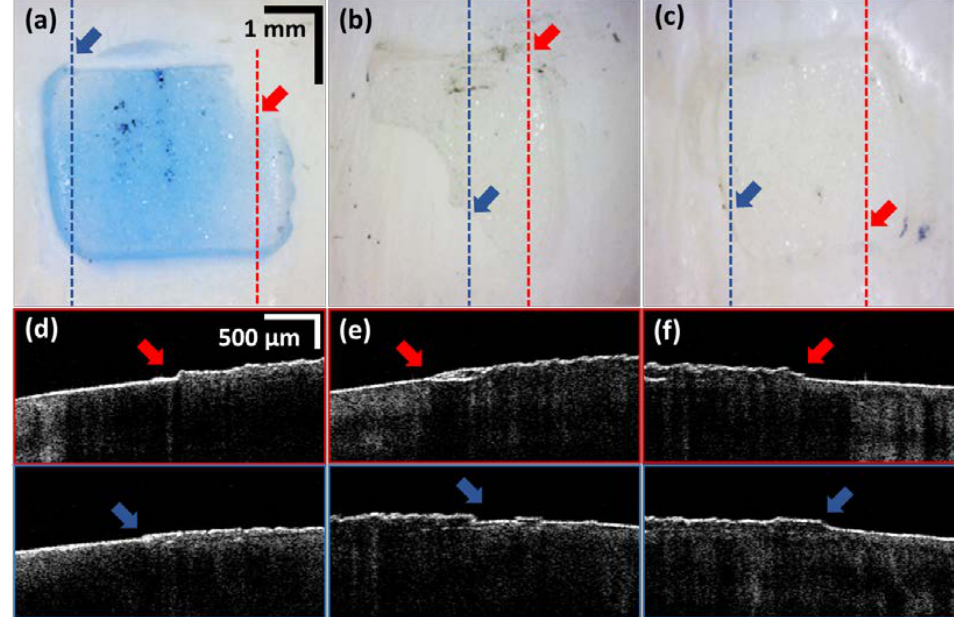
Figure 4. The images of the optical microscope of the samples and the cross-section images taken with OCT: ( a – c ) are images of optical microscope, and ( d – f ) are OCT cross-sectional images acquired from the regions marked with red and blue dash lines. The regions of thin residual adhesive, which are hard to be identified with the optical microscope, were clearly distinguished from OCT visualizations.